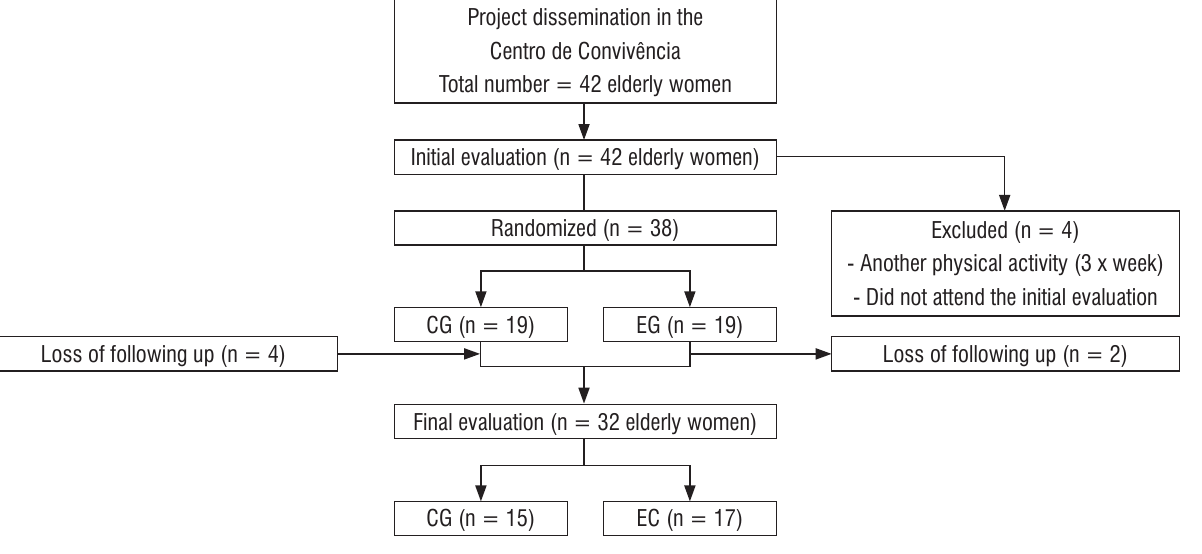
Figure 1 - Constitution of the